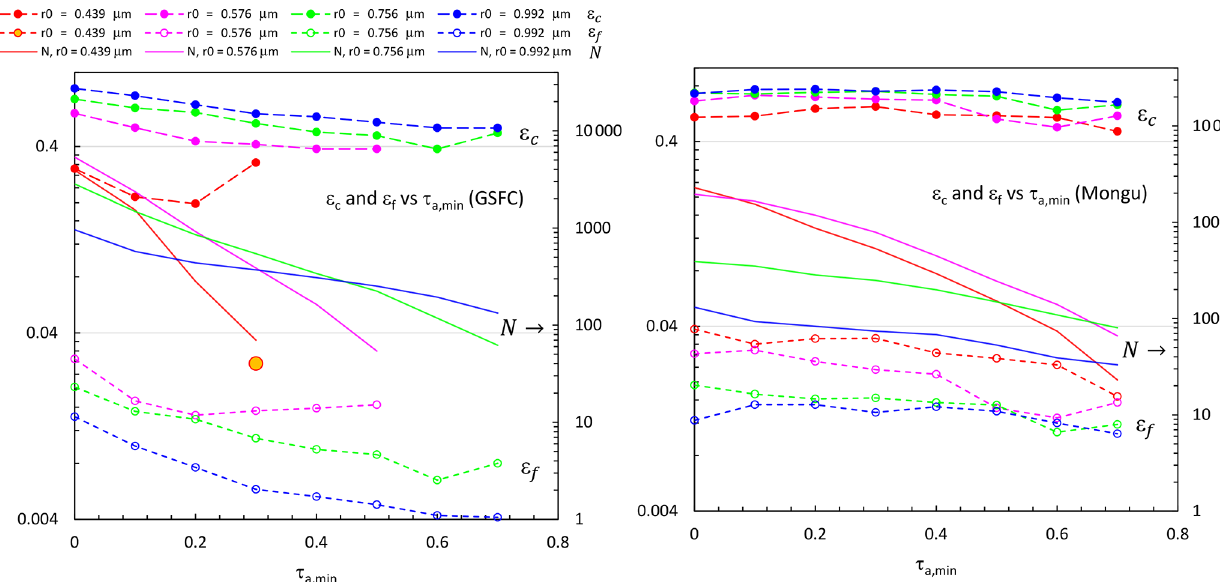
Figure 9. GSFC and Mongu variations of regression-derived values of ε c and ε f as a function of a minimum value of total AOD at 500nm ( τ a , min ) employed in the η (cid:48) vs. η regressions (The decreasing point dispersion (the approach of τ (cid:48) the regression-derived precision of the ε c and ε f values should, for that reason alone, generally increase with larger values of τ f . However, offsetting this type of influence on an increase in precision is the decrease in the number of regression points and the squeeze in τ f and τ (cid:48) variability as the η = η (cid:48) singularity is approached.) (to be clear, Fig. 9 represents an exercise in testing the sensitivity to τ a , min : the regressions of Fig. 6 and the regression-derived ε c and ε f values of Fig. 7 were obtained with no restrictions on the matched AERinv and SDA retrievals). Same color scheme as Figs. 6 and 7. The legend of the Mongu plot is the same as the GSFC legend. The number of matched retrievals ( N ) is also shown (right-hand axis). Result are not shown in cases where N < 20. The large orange-filled (re-rimmed) circle in the GSFC case represents the only ε f point of the r 0 = 0 . 439µm regressions that both survived the N < 20 rejection criterion and did not yield a negative ε f